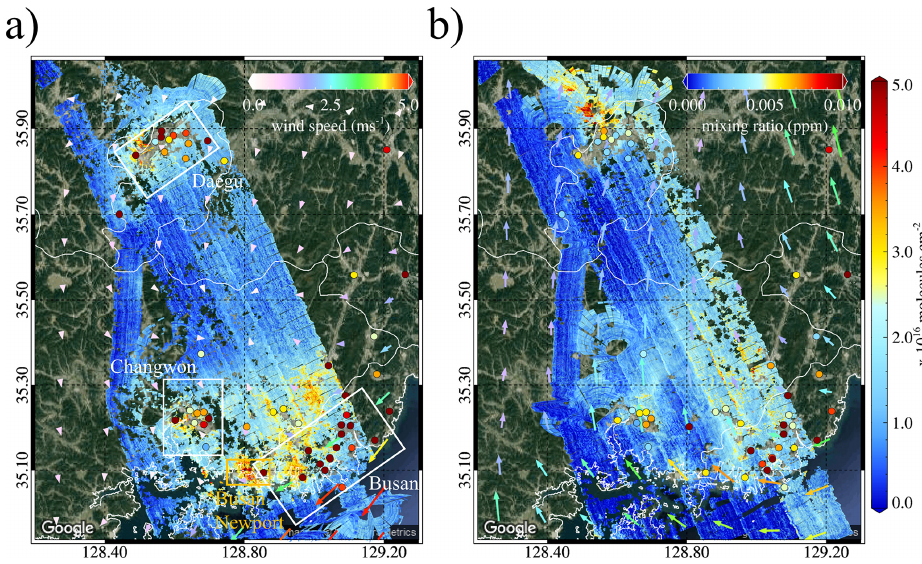
Figure 8. Tropospheric NO 2 VCD in the Busan metropolitan region in the (a) morning and (b) afternoon of 10 June 2016. The wind speed (color scale) and wind direction (arrows) at 1000hPa pressure level were obtained from the Unified Model (UM) simulations. The white boxes represent the major cities of Busan, Daegu, and Changwon. The orange box represents Busan New Port (the background RGB image is from Google Earth; https://www.google.com/maps/, last access: 19 January